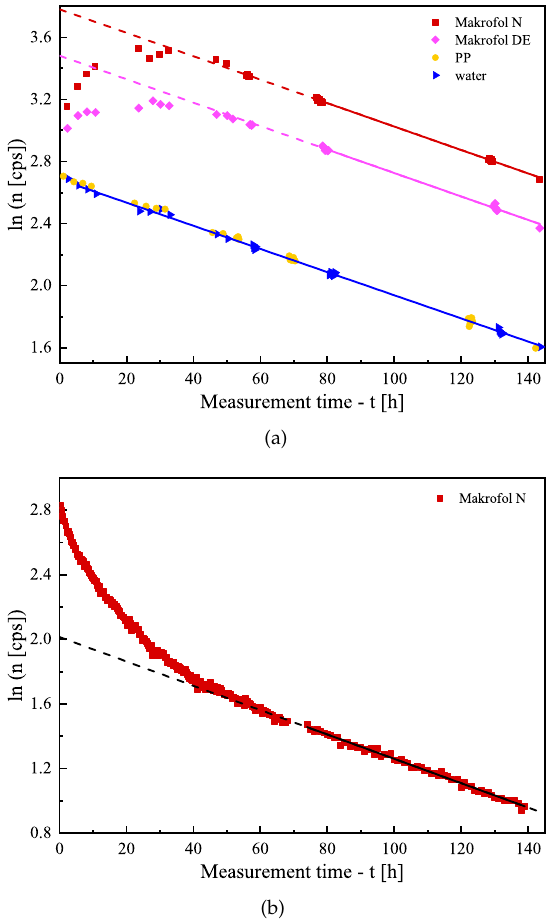
Figure 1. Signal follow-up (in semi-logarithmic scale) of several samples measured at the liquid scintillation counter in Cherenkov-counting mode: ( a ) unexposed polymer foils immersed in water with radon activity and ( b ) a Makrofol N foil exposed to radon immersed in distilled water. The points are the experimental data (the uncertainties—not shown, are within the size of the symbols), the solid line is a linear fit of the data, and the dashed line is extrapolation of the fit for better visualization. The signals decrease linearly in semi-log. scale (i.e., exponentially) and the slopes are very